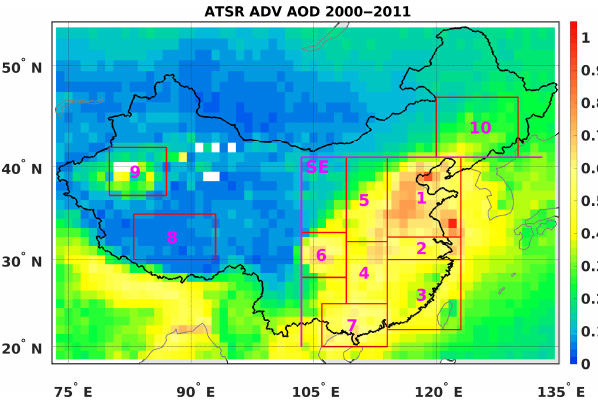
Figure 2. Regions over mainland China selected for further study of seasonal, interannual and long-term behavior of the AOD, over- laid on the ATSR-retrieved (ADV version 2.31) 12-year aggregated AOD map. Mainland China is indicated by the black line. Figure shows the 10 selected regions over China and a larger area over SE China indicated by